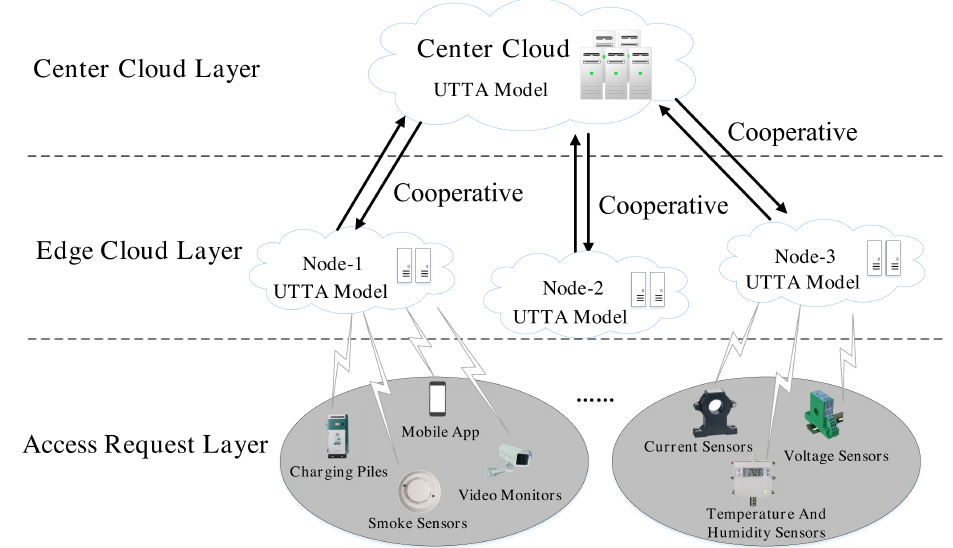
Figure 1. The end-edge-cloud cooperative authentication